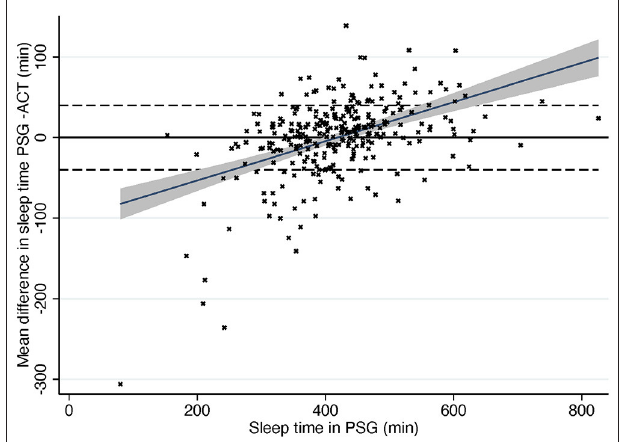
FIGURE 2 | Difference in sleep time compared to total sleep time in PSG. Dashed line, ± 40min according to AASM criteria. Gray area, 95% confidence interval for regression line. Solid line, mean difference. PSG, polysomnography; ACG, actigraphy.